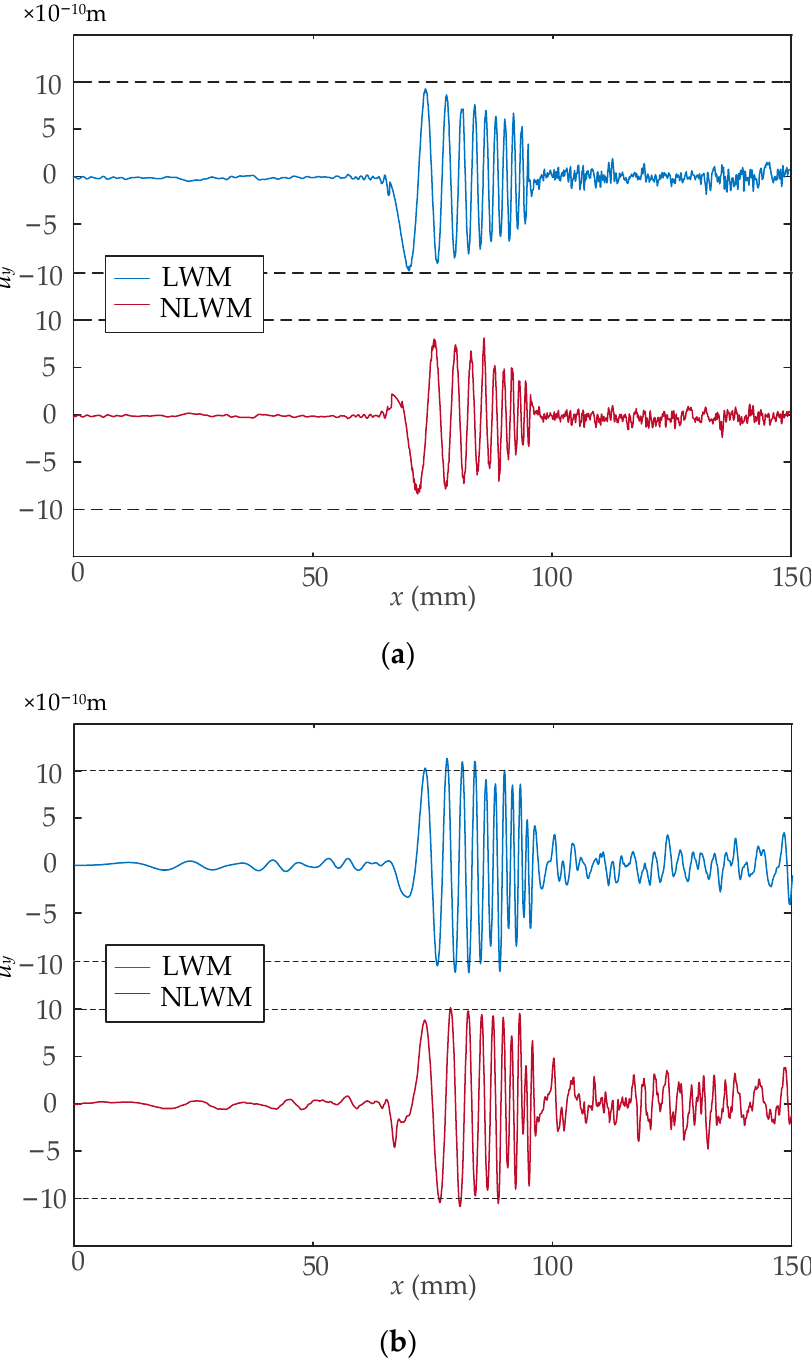
Figure 9. The y -direction displacement component along the surface of the sample: ( a ) case 1; ( b ) case 2.